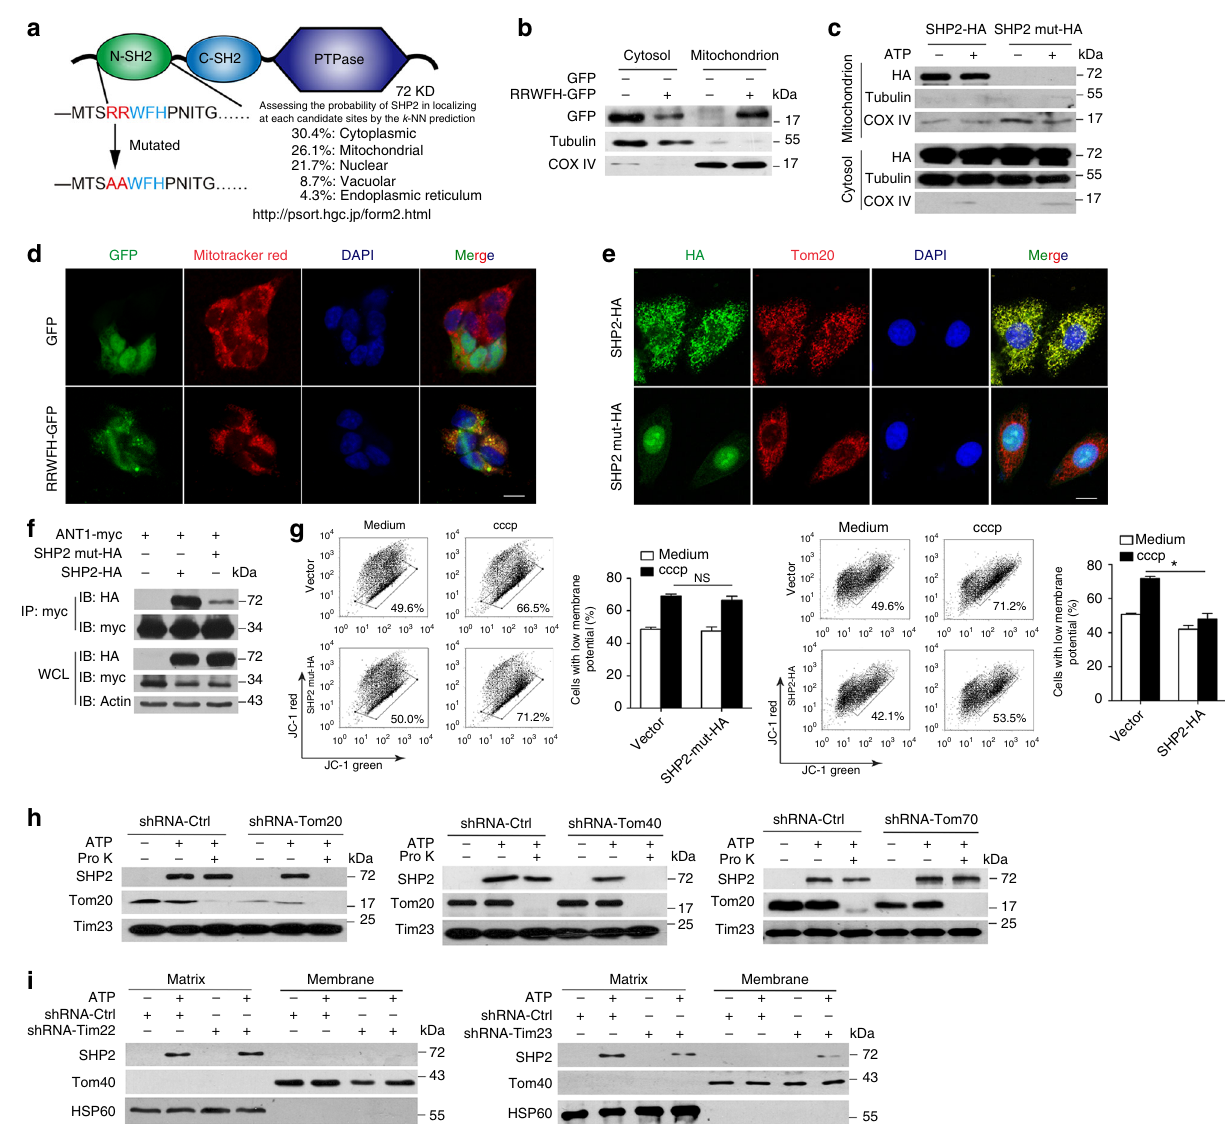
Fig. 6 Tom20/Tom40 and Tim23 complex are necessary for SHP2 translocation to mitochondrial matrix. a Predication of mitochondrial target sequence in SHP2 by PSORT II. b Immunoblot analysis of GFP localization in submitochondrial fractions from HEK293T cells which were transfected with GFP or RRWFH-GFP plasmid. c Immunoblot analysis of SHP2 localization in submitochondrial fractions from HEK293T cells which were transfected with SHP2-HA or SHP2-mut-HA (mitochondrial target sequence mutation, RRWFH mutated to AAWFH) plasmid followed by ATP treatment (5 mM, 30 min). d Immuno fl uorescence analysis mitochondrial localization of GFP-tagged RRWFH motif in HEK293T cells. Scale bar, 10 µ m. e Immuno fl uorescence analysis mitochondrial localization of SHP2-HA or SHP2-mut-HA plasmid in HEK293T cells. Scale bar, 10 µ m. f Co-immunoprecipitation (Co-IP) analysis of the interaction of SHP2 and ANT1 in HEK293T cells, which were transfected with ANT1-myc and SHP2-HA or SHP2-mut-HA. g Flow cytometry analysis of mitochondrial membrane potential by JC-1 staining in HEK293T cells which were transfected with SHP2-HA or SHP2-mut-HA plasmid followed by cccp treatment (20 µ M, 1 h). h Immunoblot analysis of SHP2 in mitochondria after Tom20 or Tom40, or Tom70 sliencing. Endogenous Toms were separately knocked down by its corresponding shRNAs in THP-1 cells followed by ATP treatment (5 mM, 30 min), then mitochondria were isolated and incubated with 40 μ M proteinase K (Pro K) for 30 min. Tom20 in mitochondrial outer membrane (MOM) and Tim23 in mitochondrial inner membrane (MIM) were used as control, respectively. i Immunoblot analysis of SHP2 expression in submitochondrial fractions from THP-1-derived macrophages treated with ATP (5 mM, 30 min) after Tim22 or Tim23 silencing. * P < 0.05 by Student ’ s t -test, NS represents no signi fi cance. Data are representative of three independent experiments (mean and SEM of three independent samples in g